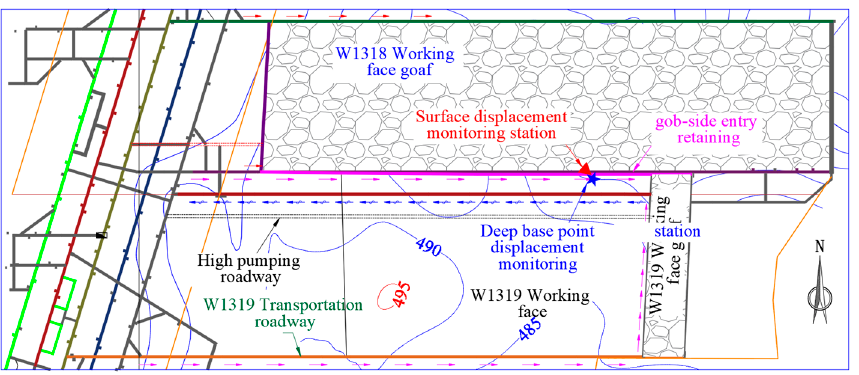
Figure 21. Position calibration of mine pressure monitoring.